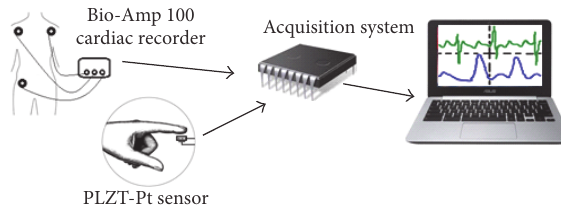
Figure 3: A , B , and C records acquired.